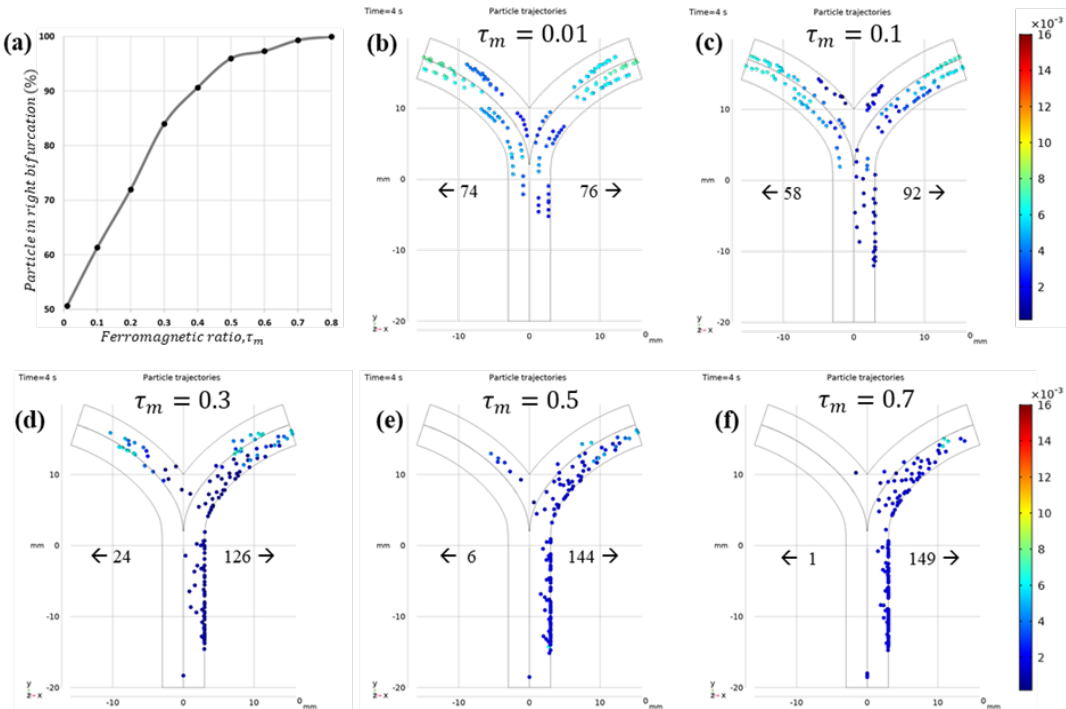
Figure 8. ( a ) Microrobots (%) flowing through required bifurcation and their dependence on 𝜏 𝑚 . ( b–f ) Microrobot trajectories under the influence of 𝛻𝐵 = 1 𝑇/𝑚 with FFP at point ① and its dependence on 𝜏 𝑚 : ( b ) 𝜏 𝑚 = 0.01 , ( c ) 𝜏 𝑚 = 0.1 , ( d ) 𝜏 𝑚 = 0.3 , ( e ) 𝜏 𝑚 = 0.5 , and ( f ) 𝜏 𝑚 = 0.7 .